Question: Give a one-sentence summary of this figure.
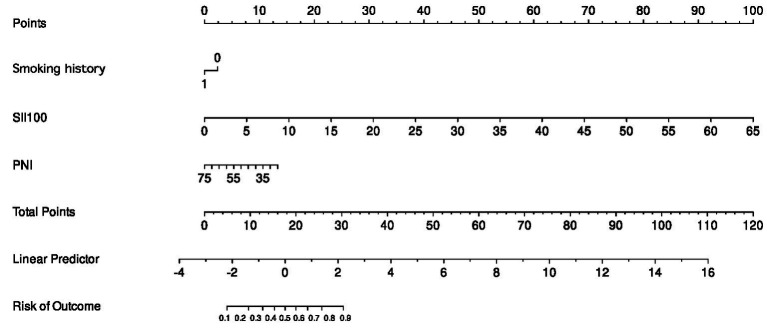
Answer: ROC curve of validation set.